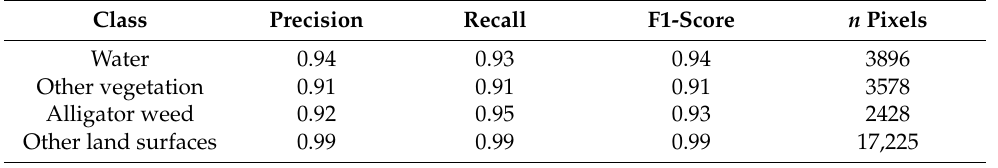
Table 5. Summary of 2010 random forests classifier accuracy